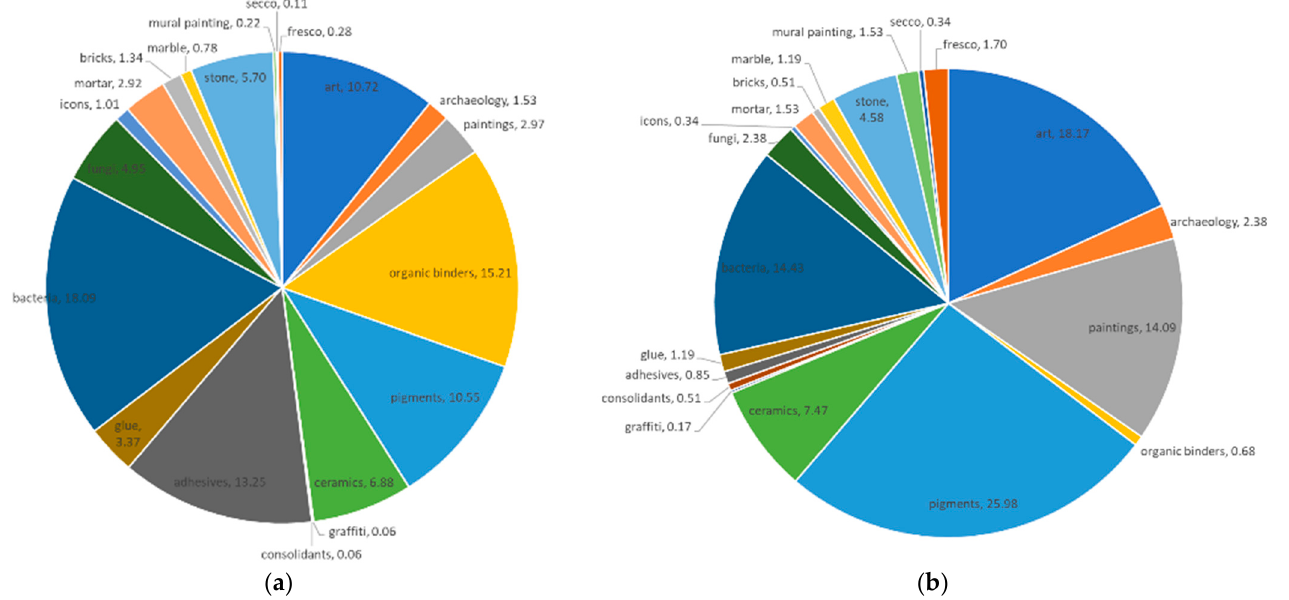
Figure 1. Graphical representation of the input of the search terms for the ( a ) Elsevier, Springer and Wiley; ( b ) WoS databases.